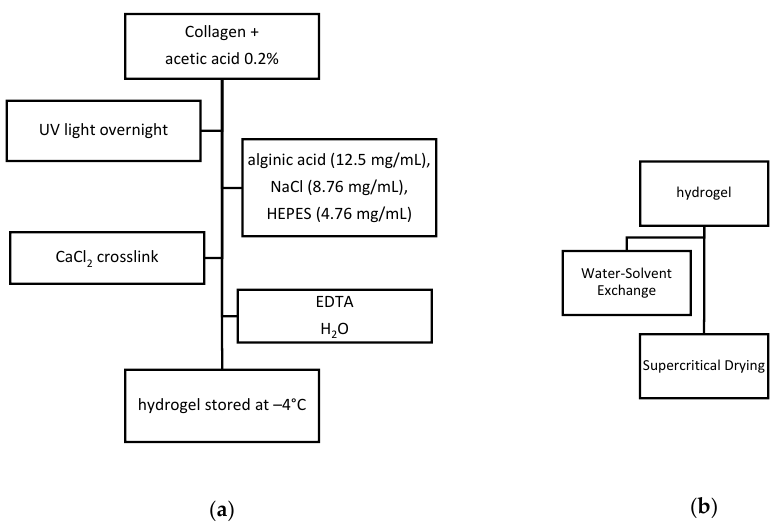
Figure 3. Synthesis process: ( a ) Synthesis of collagen–alginate hydrogel; ( b ) synthesis of aerogel